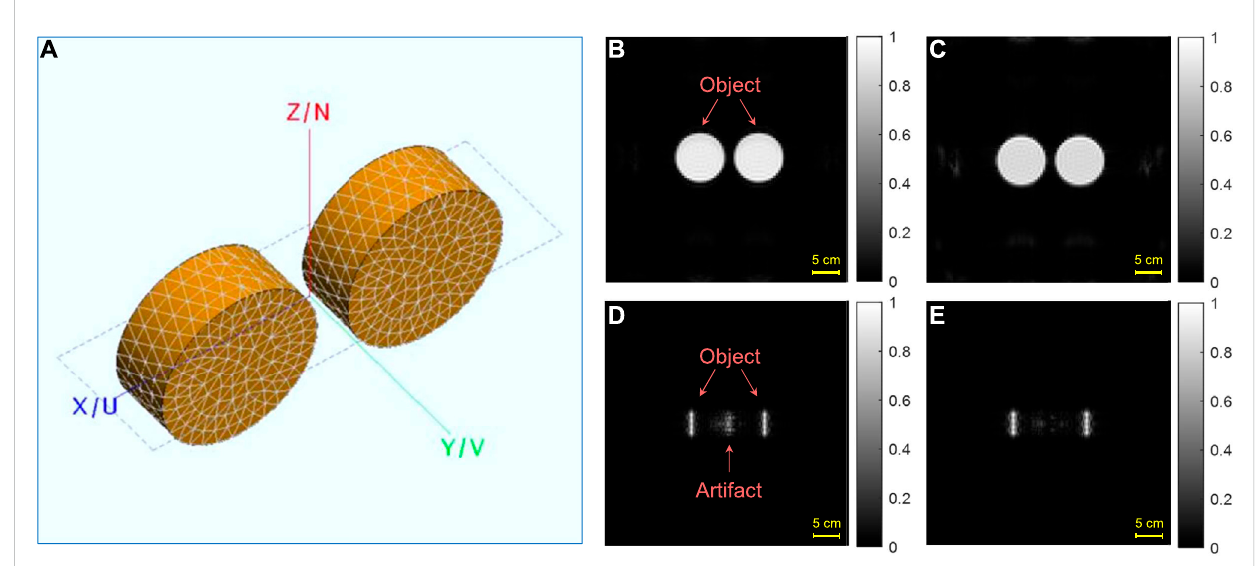
FIGURE 3 Simulated imaging results of two spaced aluminum cylinders. (A) 3D mesh structure diagram of two spaced aluminum cylinders for imaging simulation. (B) Co-linearpolarizationimaging(Conventionalimaging)inthedirectionalong y -axis. (C) Cross-circularpolarizationimaginginthedirection along y -axis. (D) Co-linear polarization imaging (Conventional imaging) in the direction along z -axis. (E) Cross-circular polarization imaging in the direction along z -axis.